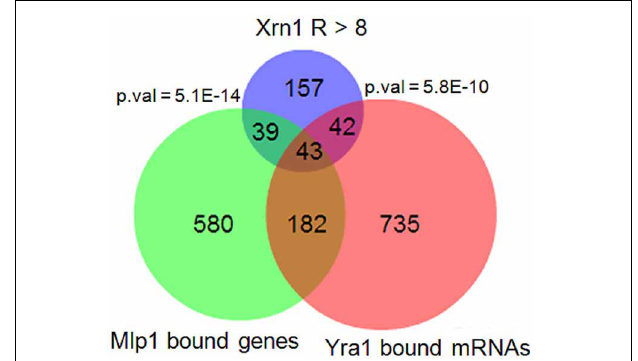
FIGURE 5 | Overlapping between Xrn1-synthegradon genes with genes bound by Mlp1 and the mRNAs bound by Yra1. The list of Xrn1-synthegradon genes (responsiveness index > 8, this work) was crossed with the genes bound by Mlp1 (Casolari et al., 2004) and with mRNAs bound by Yra1 (Hieronymus and Silver, 2003). The overlaps are statistically significant ( p -values for hypergeometric tests are shown). The overlaps with other Cse1 nuclear pore proteins studied in the same paper were also significant ( Figure S4 ), but not with